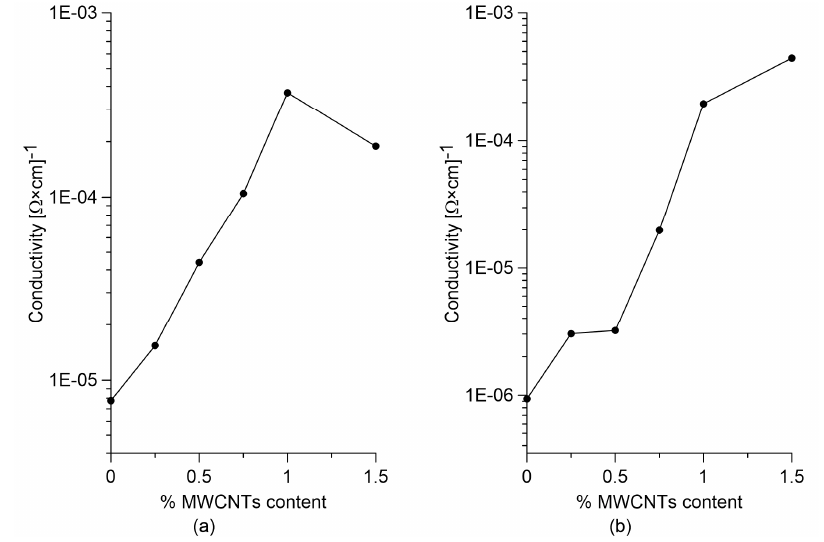
Figure 4. Electrical conductivity variation for different MWCNTs content in ( a ) cured paste samples; and ( b ) concrete samples.